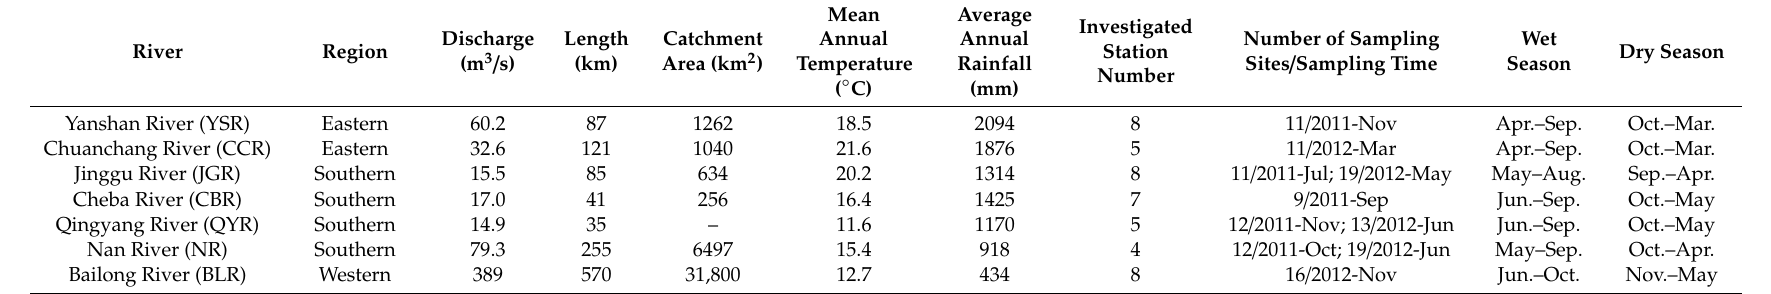
Table 1. Physical and hydrological data and sampling details regarding the seven investigated